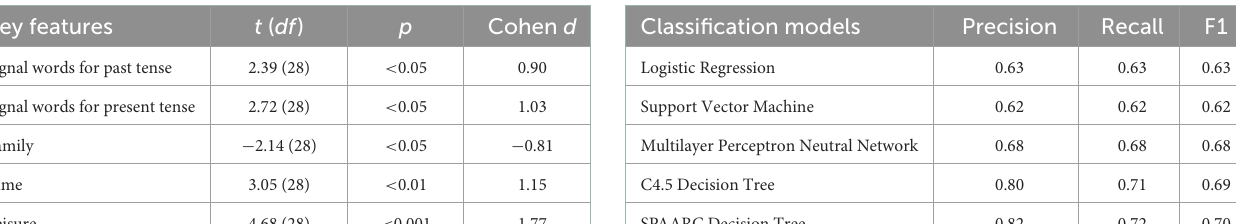
TABLE 3 Key features selection: n = 30. TABLE 4 Performance of classification models: n =